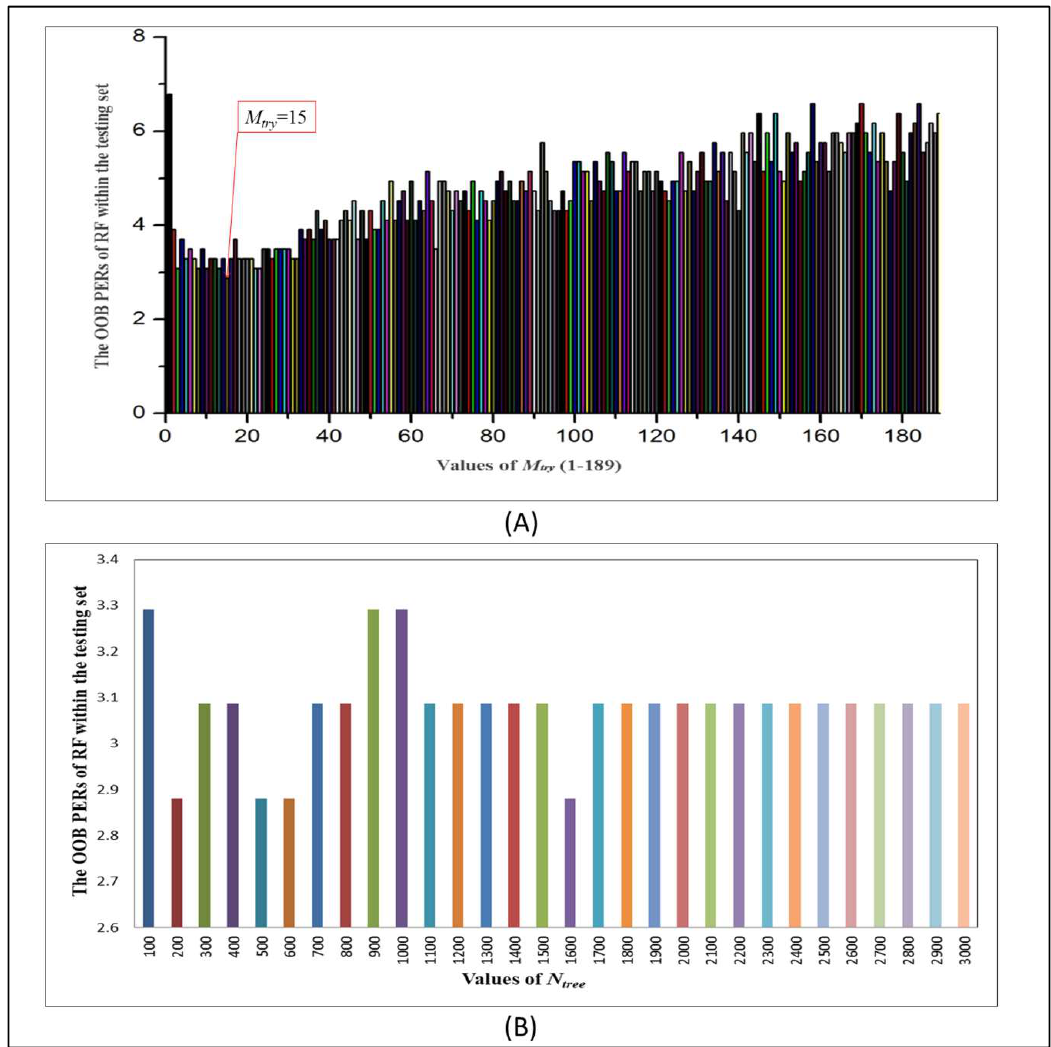
Figure 1. The effects of the different parameters on the out-of-bag (OOB) prediction error rates (PERs) of random forest (RF) within the testing set. ( A ) M try (1 ≤ M try ≤ 189); ( B ) N tree (100 ≤ N tree ≤ 3000).